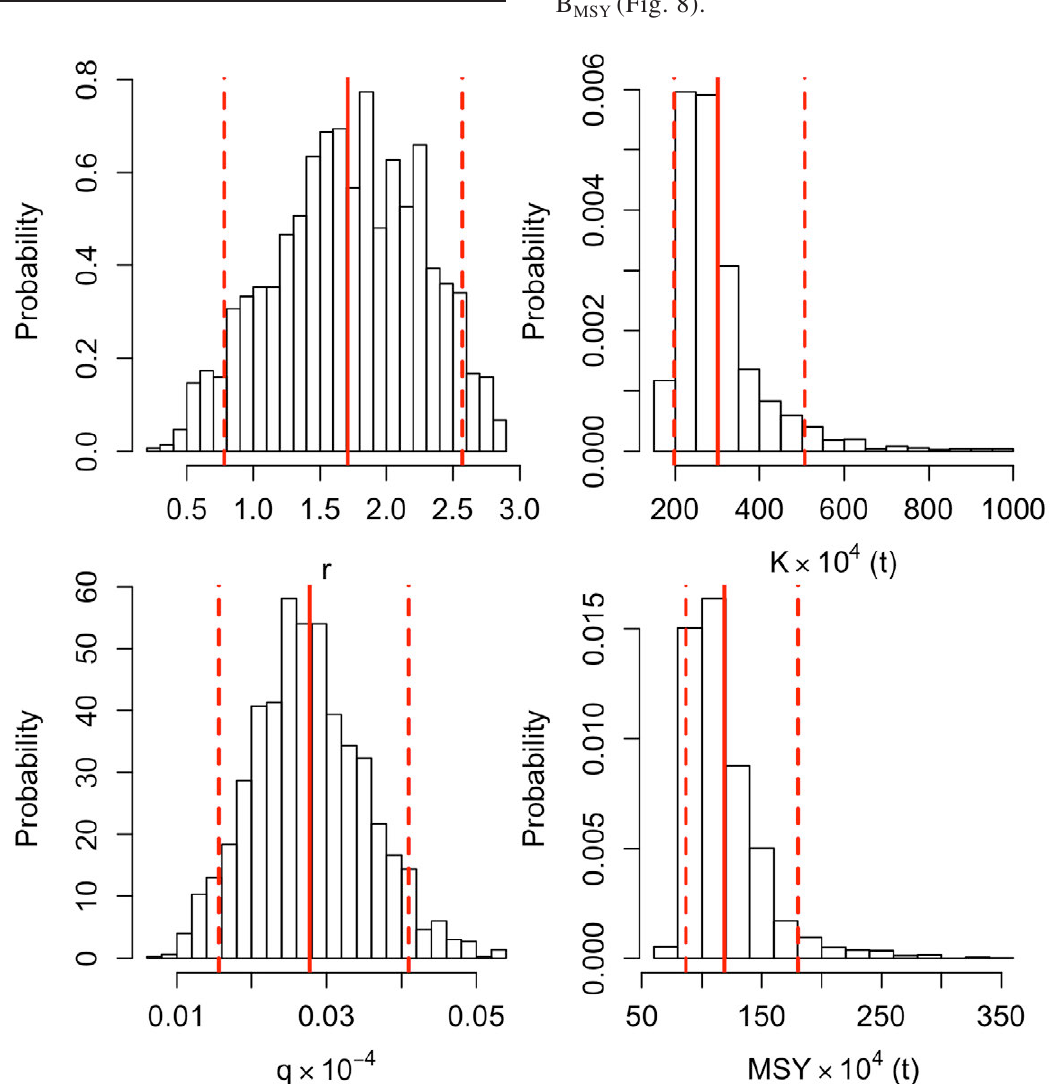
Fig. 5. – Distribution of the parameters estimated with the bootstrapped ML in the Pf-EDSP model for the D. gigas from 2003 to 2013. The red lines are the mean value for each parameter and the dotted red lines are the 95% confidence